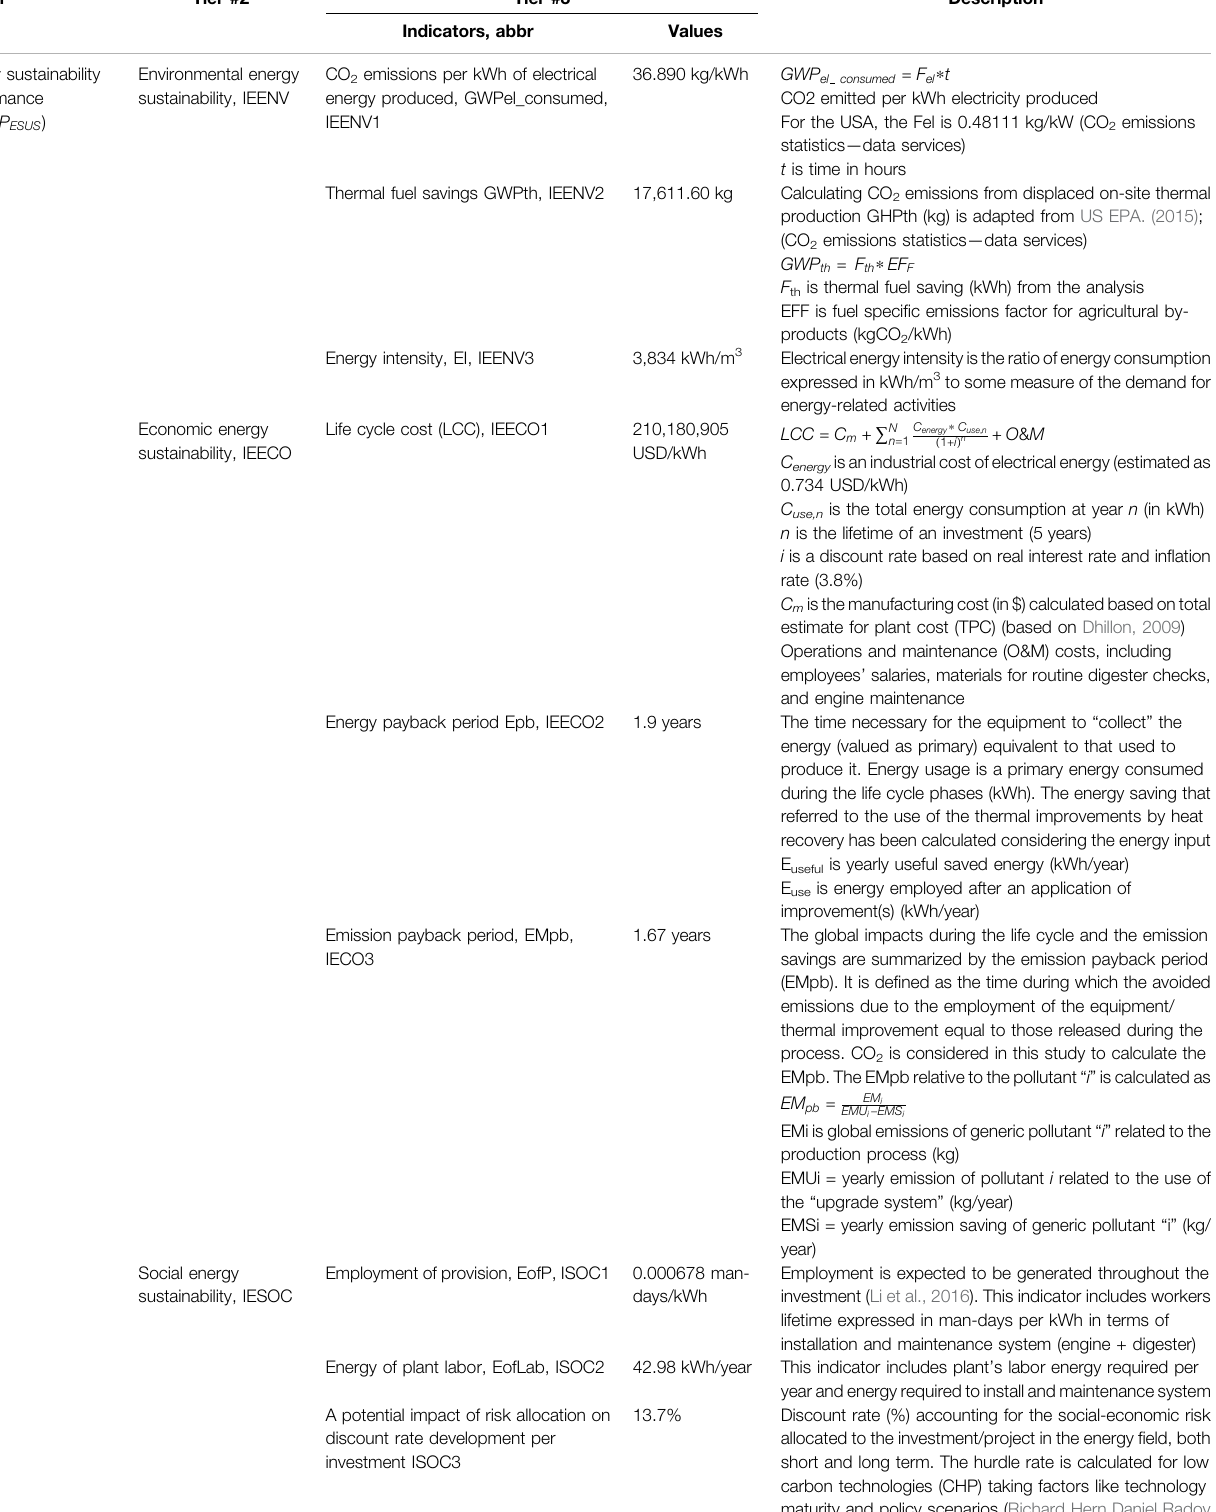
TABLE 2 | Hierarchical structure of energy life cycle indicators and their